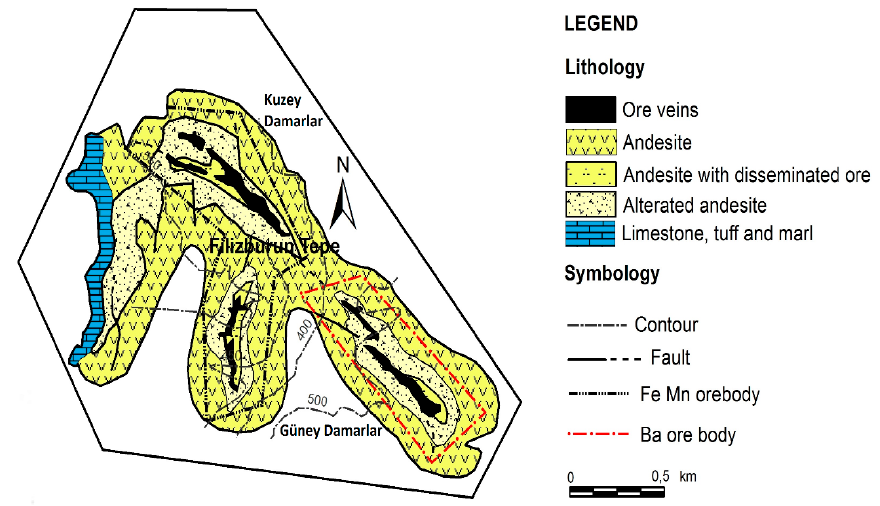
Figure 2. Local geological map of the study area, showing the ore veins, altered and unaltered andesite.